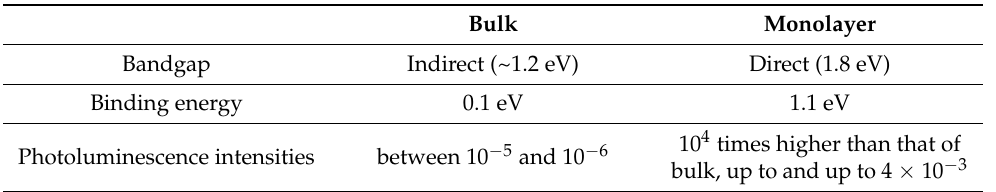
Table 2. Comparison between Bulk and monolayer MoS 2